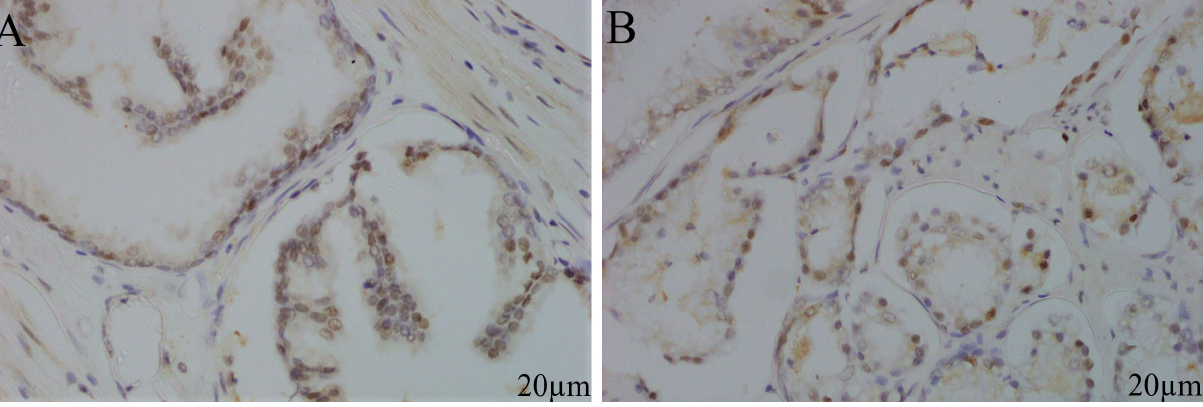
Fig. 3. Immunohistochemically stained with PCDH8. (A) Adenomatous hyperplasia. Moderate cytoplasmic, membranous and nuclear staining is observed (PCDH8, × 400). (B) Prostate adenocarcinoma. Moderate cytoplasmic, membranous and nuclear staining is observed (PCDH8, ×